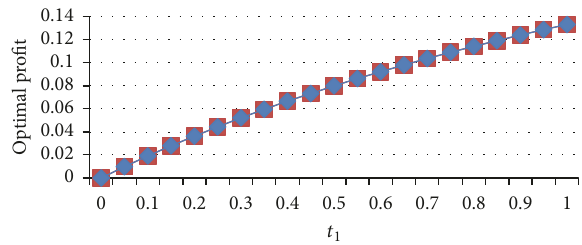
Figure 2: The optimal profit of case I with respect to time 𝑡 1 .